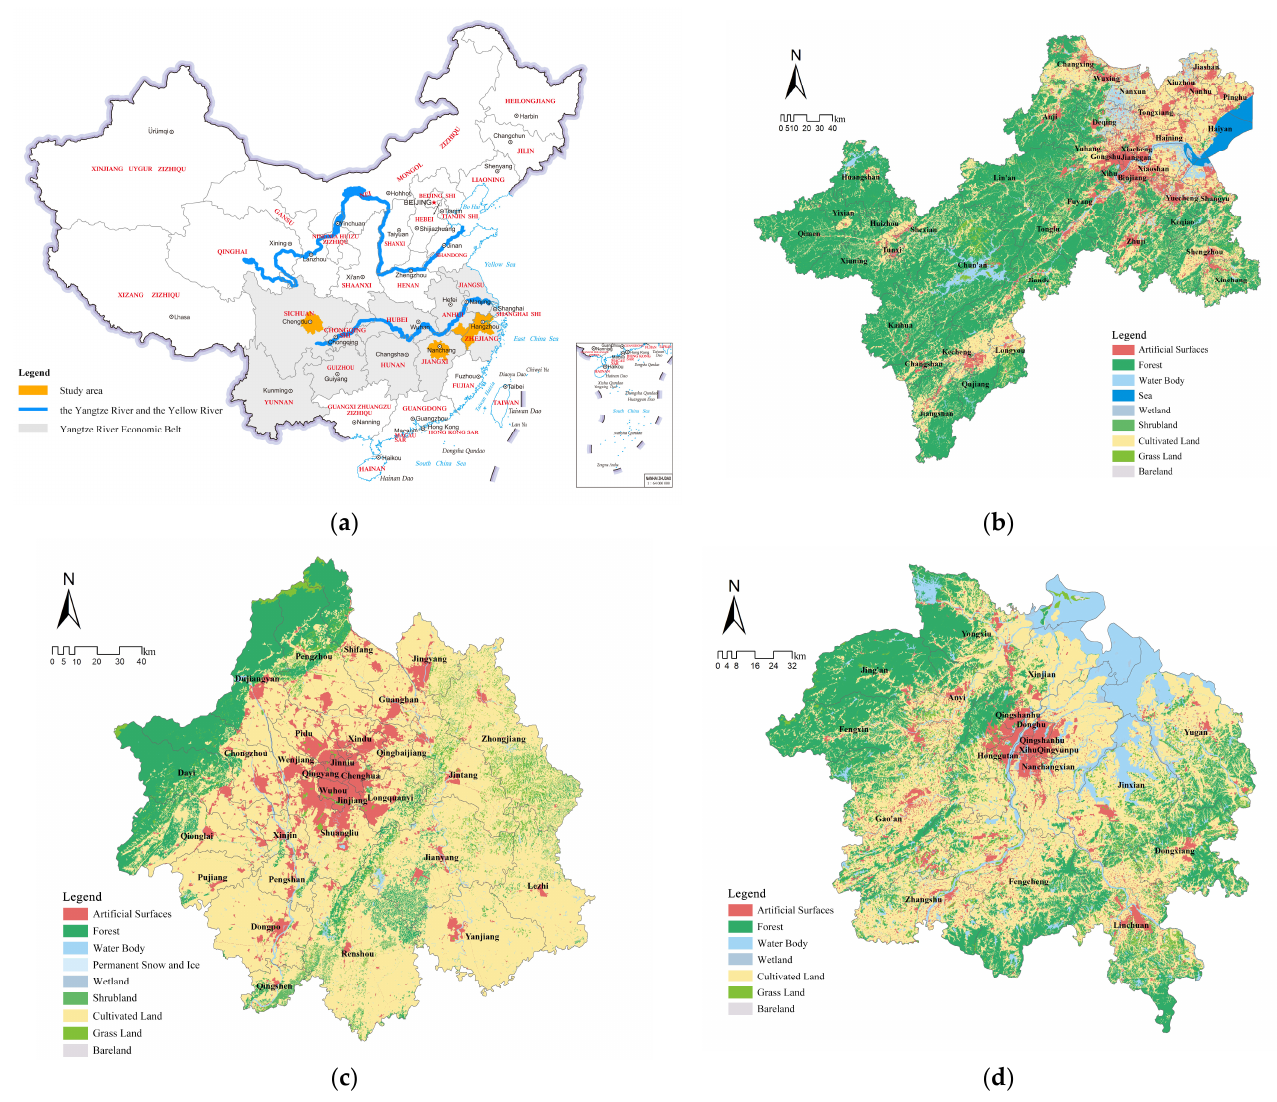
Figure 1. Study areas. ( a ) Locations of the study areas in China. ( b – d ) land use of the Hangzhou, Chengdu, and Nanchang metropolitan areas, respectively.